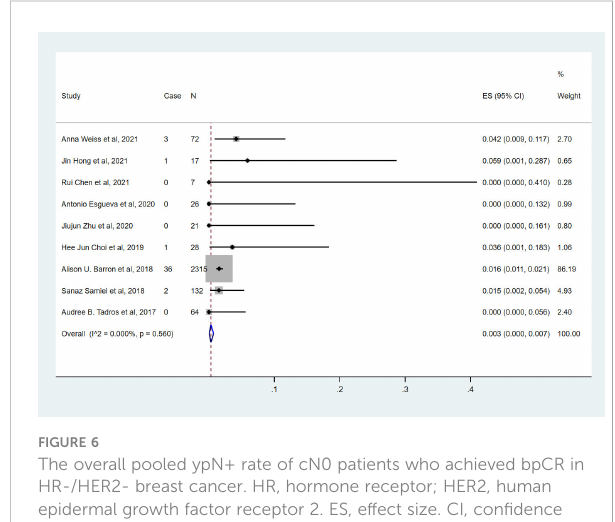
FIGURE 6 The overall pooled ypN+ rate of cN0 patients who achieved bpCR in HR-/HER2- breast cancer. HR, hormone receptor; HER2, human epidermal growth factor receptor 2. ES, effect size. CI, con fi dence interval. Effect size was used to estimate the ypN+ rate of each study. Con fi dence intervals determine the consistency and reliability of the mean estimated effect size. Diamonds indicate effect